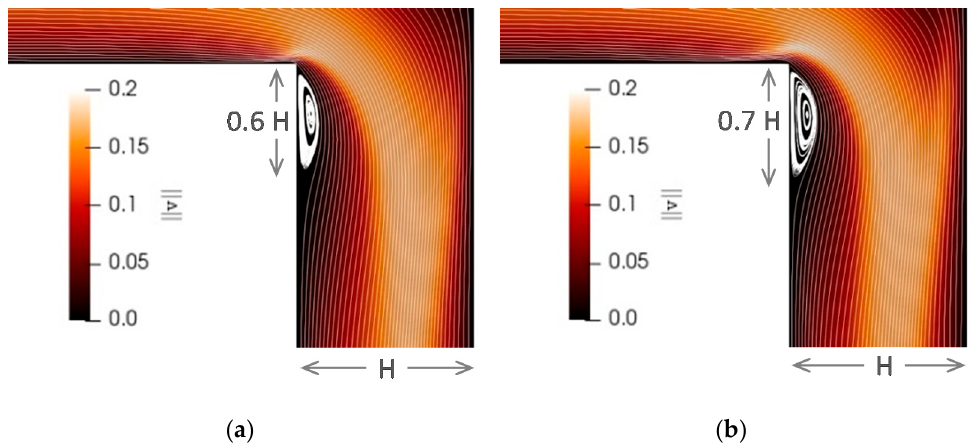
Figure 8. Downstream inertial vortices, Re = 50. Effect of Weissenberg Number (Polymer flow): ( a ) Wi = 0.5 and El = 0.01; ( b ) Wi = 1.0 and El = 0.02.